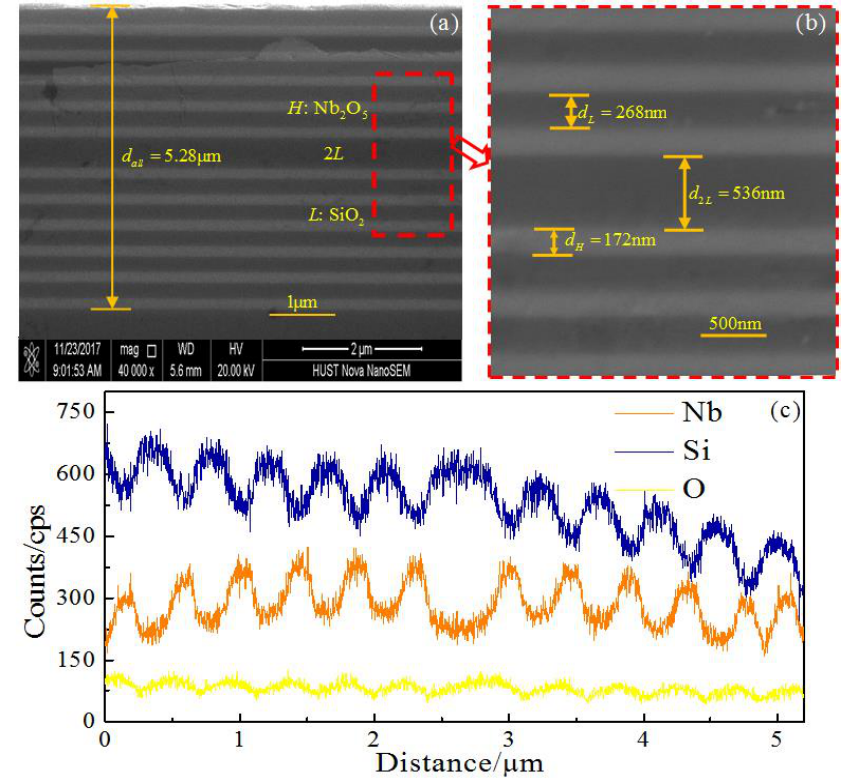
Figure 3. SEM image of the fabricated quasi-one-dimensional PC-based NBF cross-section: ( a ) total lattice view; ( b ) middle layers views; and ( c ) component analysis EDS diagram of each layer.